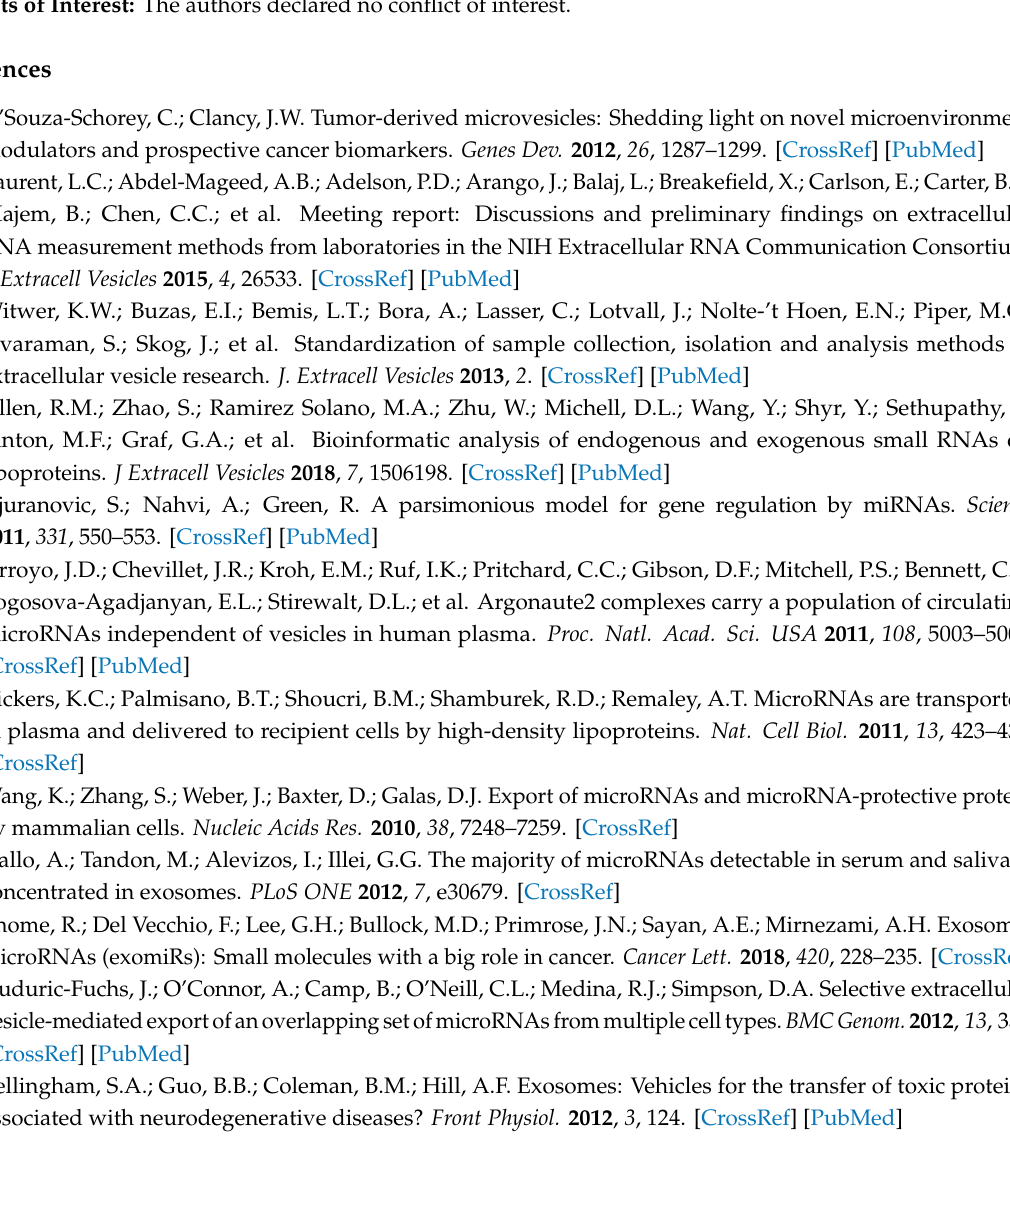
Figure S1: Size distribution analysis using the Dynamic Light Scattering (DLS); Table S1: Demographic information and clinical diagnosis of volunteers who provided plasma samples for miRNA